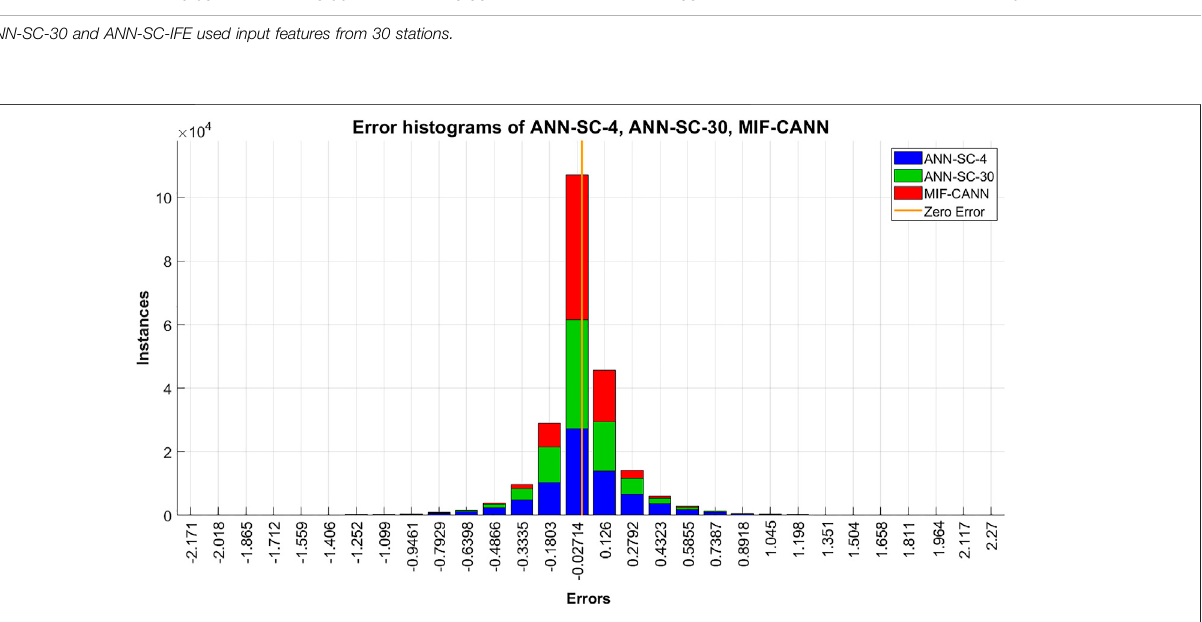
Frontiers in Energy Research |